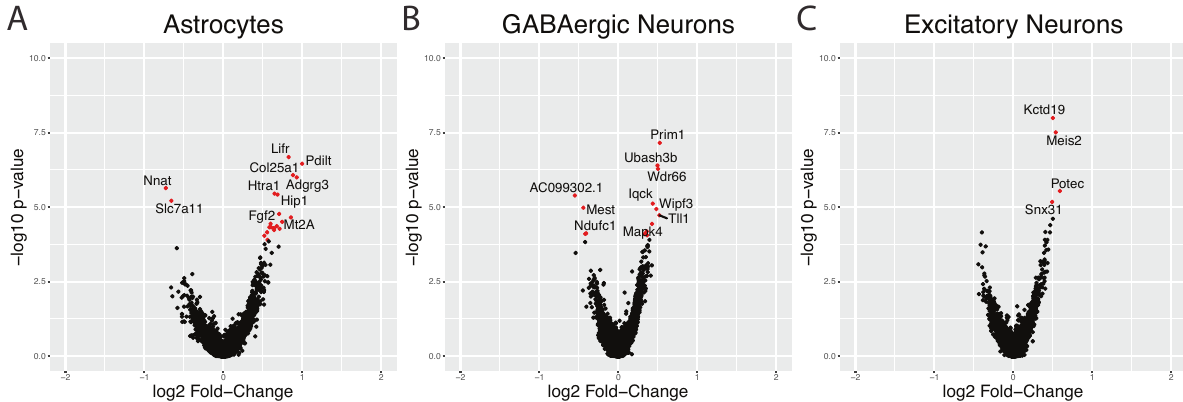
Fig. 2 Alcohol withdrawal is associated with differential gene expression in astrocytes and neurons in the CeA. Volcano plots are shown for the three cell types with the greatest numbers of differentially expressed genes (Astrocytes A , GABAergic Neurons B , and Excitatory Neurons C ). Genes in red indicate signi fi cant differential expression based on adjusted p values of <0.05, and a log2 FC of >±0.25. The top ten differentially expressed genes are